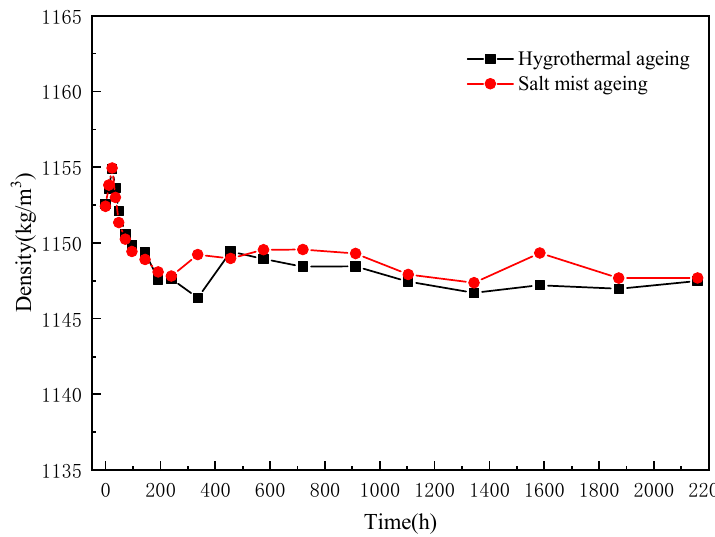
Figure 7. Changes in the density of the epoxy resins before and after ageing. At the beginning of the ageing, the high water absorption led to a rapid increase in the mass, although the change in the volume of the resin lagged behind the change in the mass; therefore, the water absorption during the initial 36 h did not result in a considerable volume change. Thereafter, the resin began to expand in volume with the subsequent decrease in density. After 456 h, the density of the epoxy resins